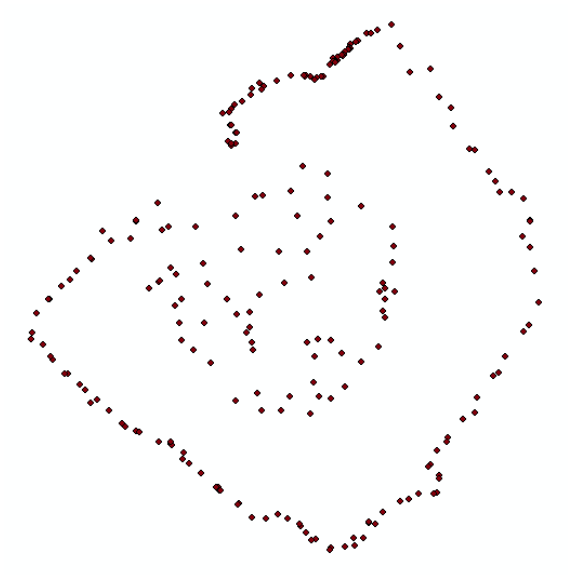
Figure 1. Point Cloud from TST data top view